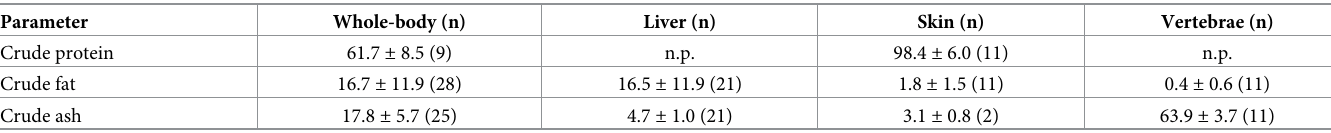
Table 3. Content of crude nutrients (% DM) in different body parts of snakes (means ± SD; n = number of samples; n.p. = not performed).